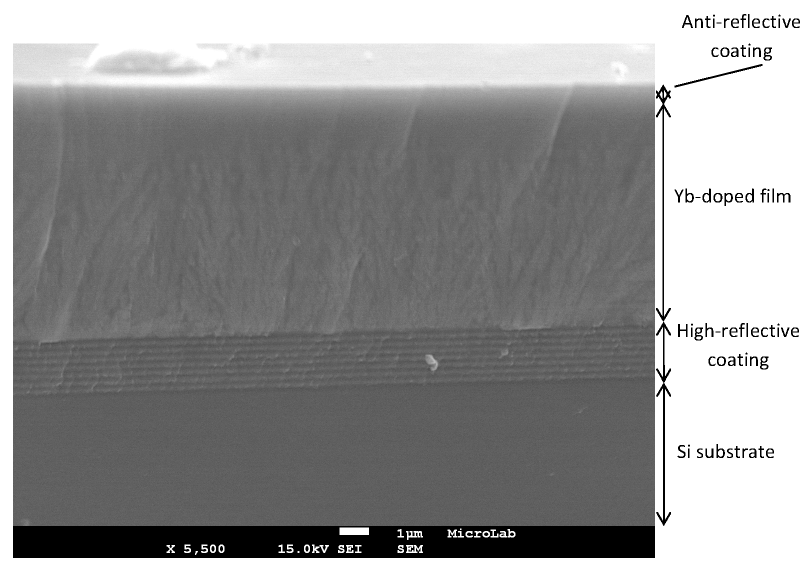
Figure 10. FEG-SEM cross section micrograph of a ~10 μ m thick active disk doped with 15 mol% YbO 1.5 , obtained in secondary electron mode. (Scale bar = 1 μ m).